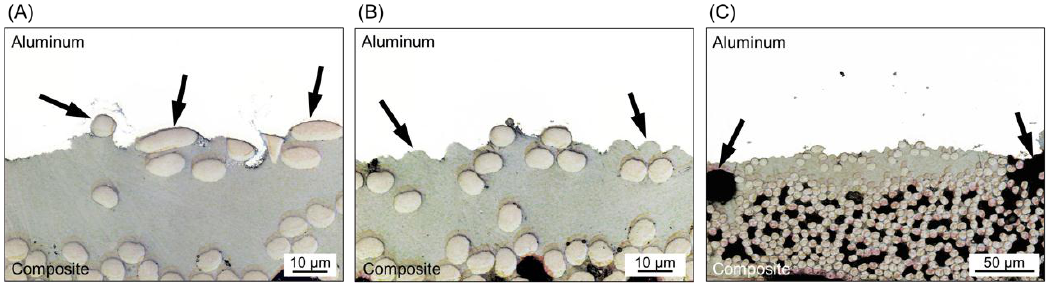
Figure 5. ( A ) Example of an AA7075-T6/CF-PPS friction spot joint along with typical ( B ) top view and ( C ) cross-section of the joints. The metallic nub is indicated with an ellipse in ( C ). The details of regions a and b are presented in Figure 6. (RS: 1900 rpm, PD: 0.8 mm, JT: 4 s, JF: 6 kN).